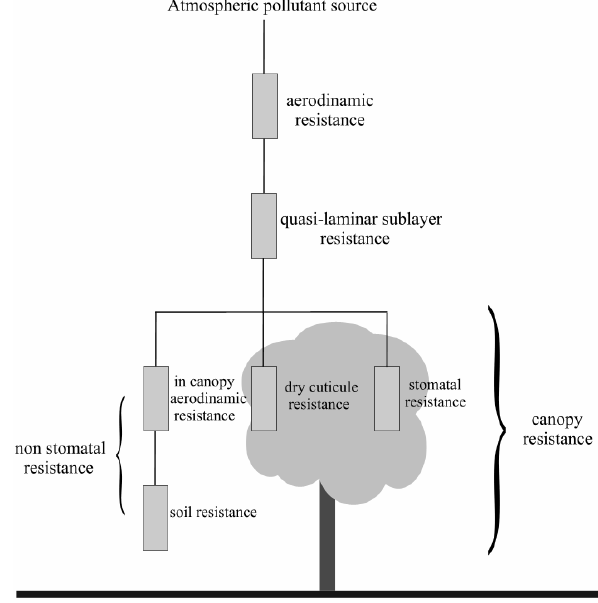
Figure 2. Calculation scheme of the resistance submodel